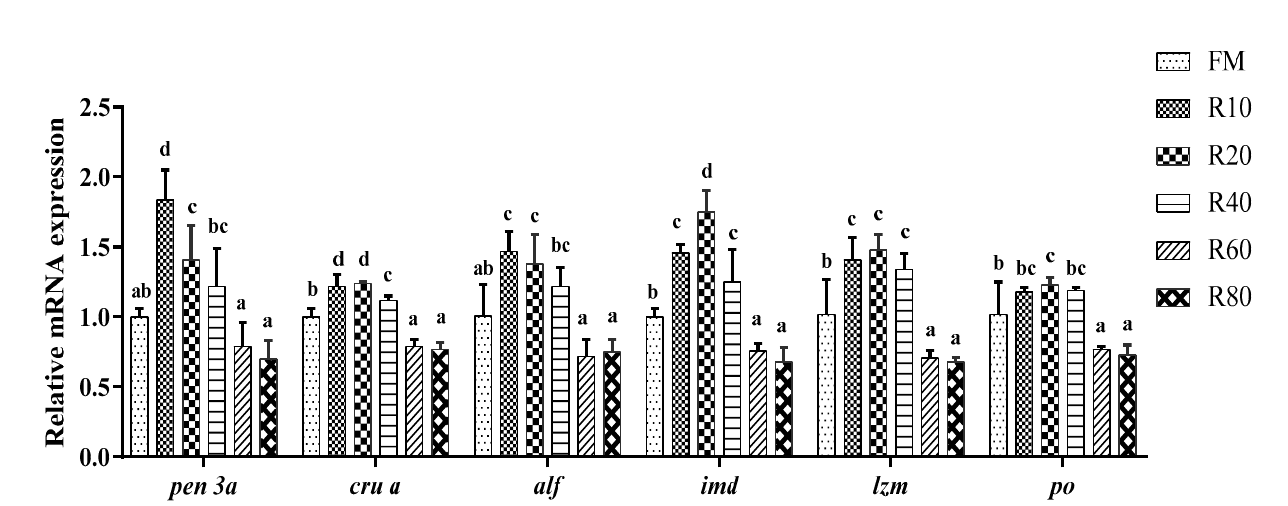
Animals 2022 , 12 , x 9 of 17 Figure 1. Effects of RPM replacing FM on hepatopancreatic protein synthesis relative mRNA ex- pression for juvenile shrimp L. vannamei . Data are expressed as means ± SD ( n = 3 ). Different letters above a bar were statistically significant different among treatments ( p < 0.05). 3.7. Effects of RPM on Hepatopancreatic Non-Specific Immune Relative mRNA Expression The penaiedin 3a ( pen 3a ) gene was significantly up-regulated in the R10 group com- pared to the FM group ( p < 0.05; Figure 2). A significantly higher level of mRNA for crustin